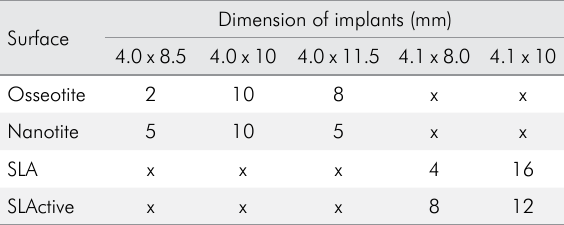
Table 1. Distribution of implants used in the study according to their commercial brands and dimensions (n = 80).